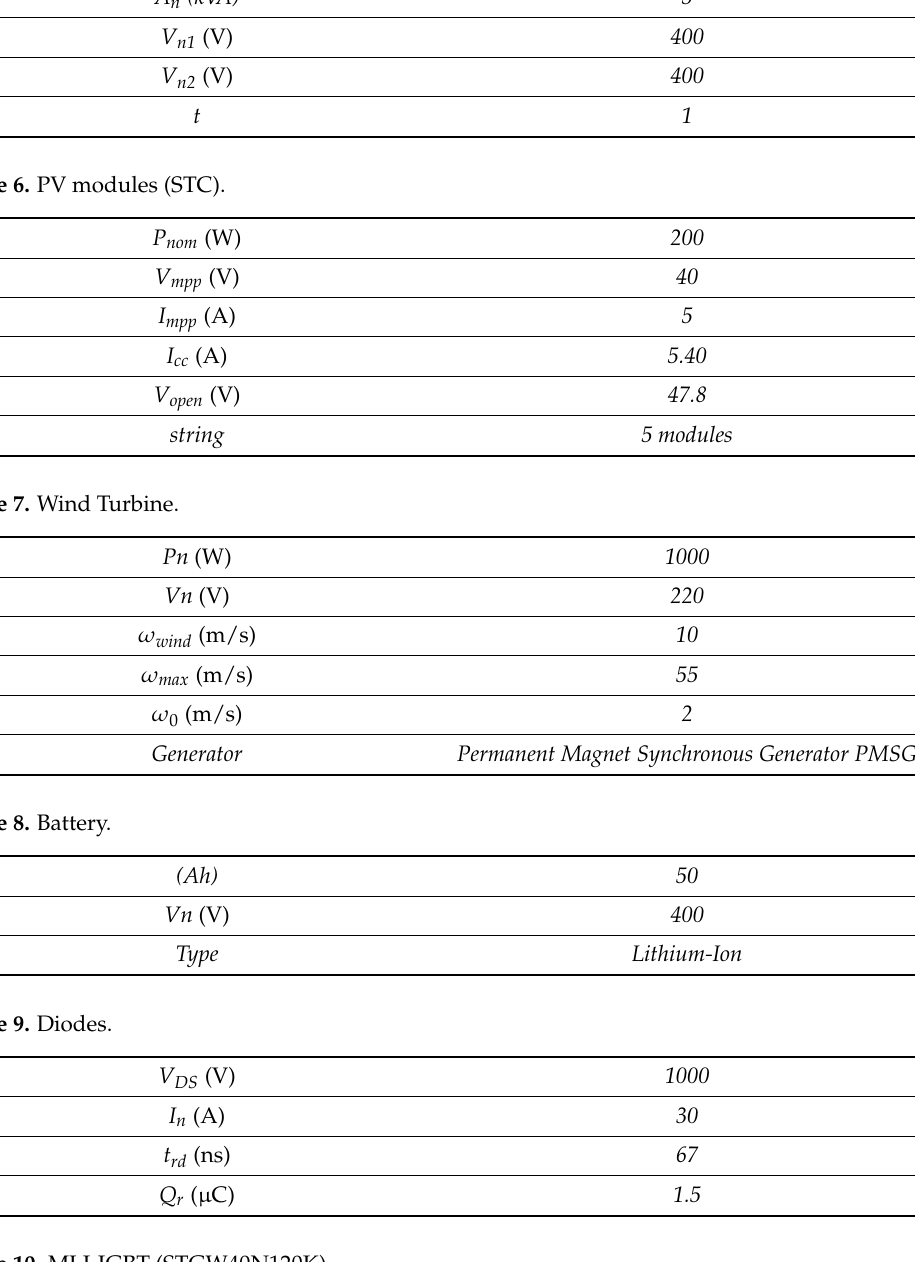
Table 10. MLI-IGBT